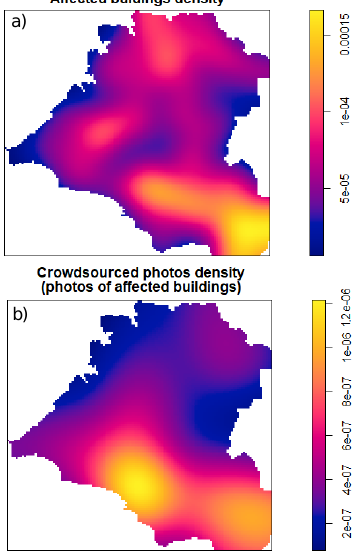
Figure 4. Kernel density heatmap for 1 km radius for a) destroyed buildings b) crowdsourced photos of destroyed